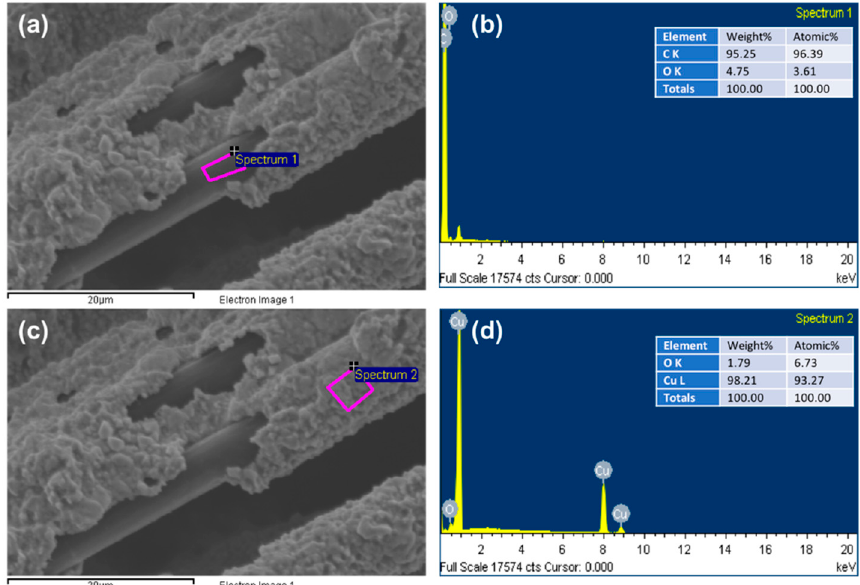
Figure 12. EDAX compositional area analysis of the carbon long fibers copper-coated using the electroplating copper-coated method with a current density of 12 μ A/cm 2 : ( a ) Selected uncoated fiber region for EDAX analysis; ( b ) EDAX elemental analysis for uncoated fiber region; ( c ) Selected coated region for EDAX analysis; and ( d ) EDAX elemental analysis for coated region.